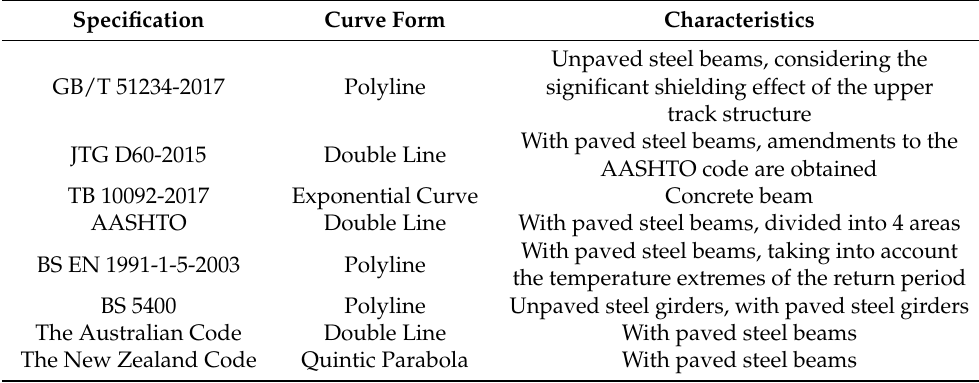
Table 1. Characteristics of temperature gradient loads in various